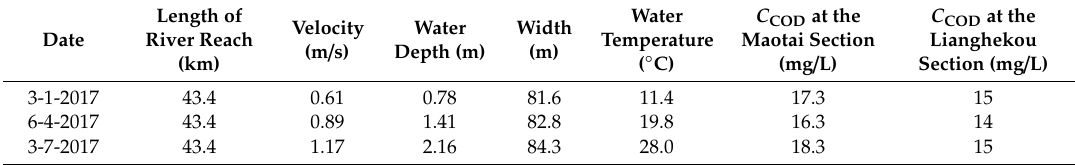
Table 4. Hydraulic conditions and water quality observation results for the Chishui River.